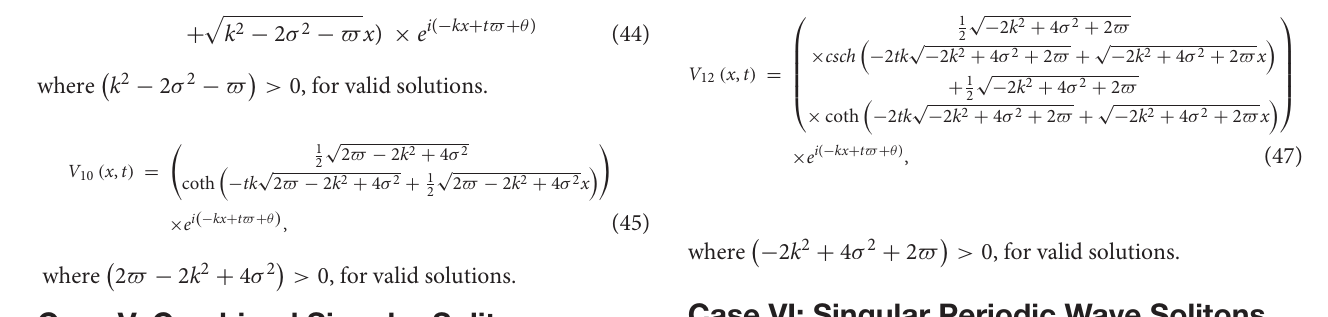
Frontiers in Physics |